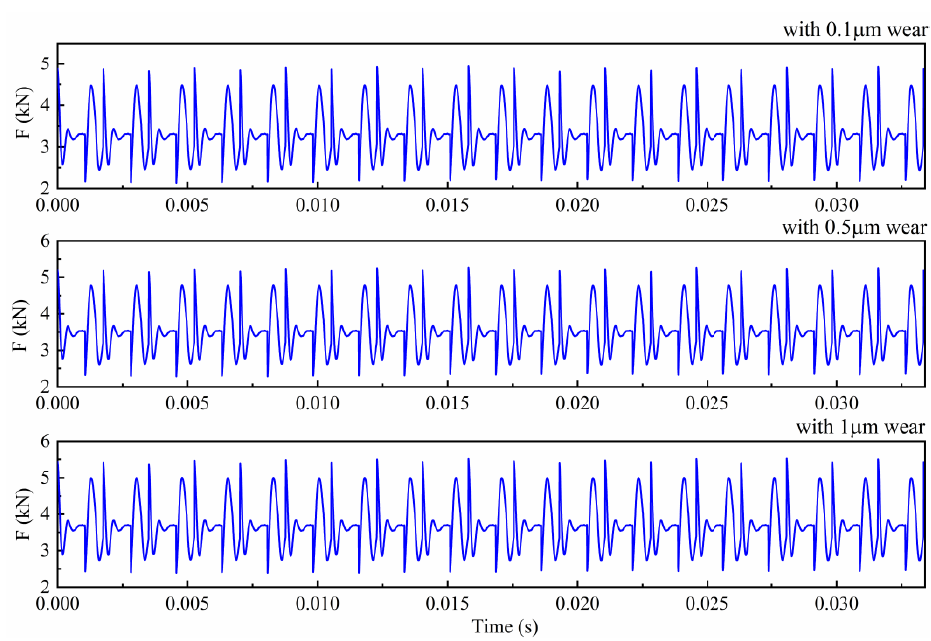
Figure 7. Spectral amplitudes of the first four meshing frequencies (MFs) alone with wear process.